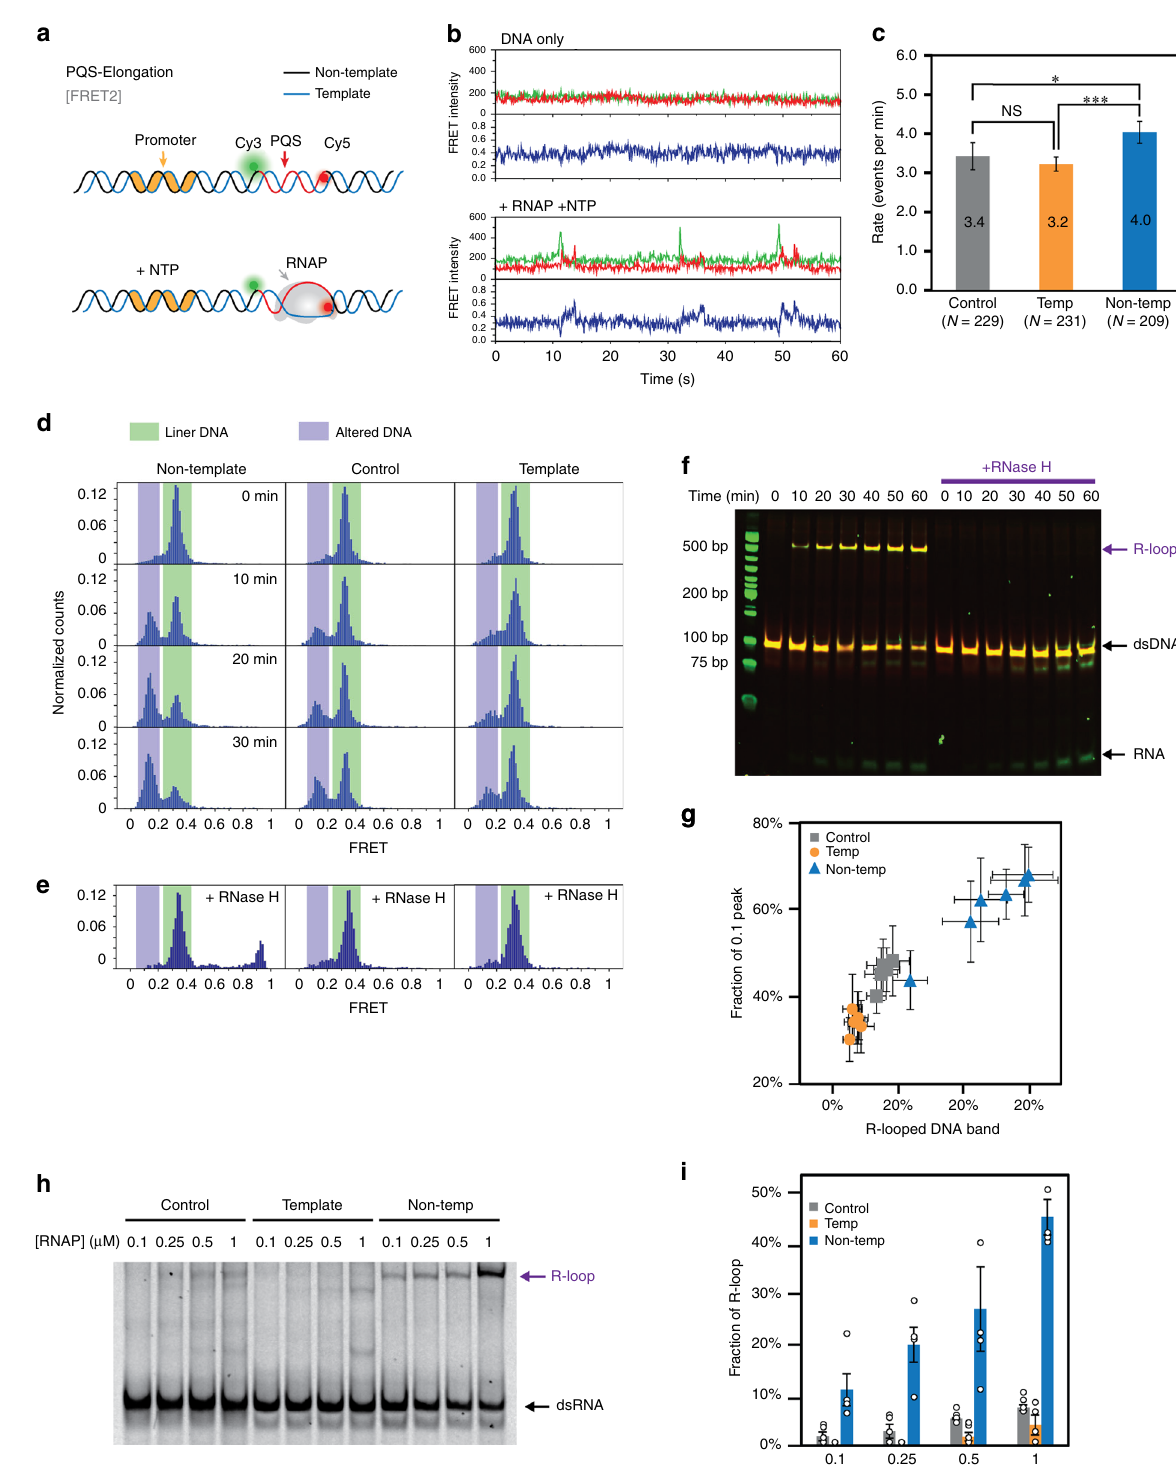
0.25 and 0.4, but no peak at 0.9 consistent with no G4 formation. Only the 0.4 peak was removed by RNase H treatment, con fi rming that 0.4 correspond to R-loop in both constructs and the 0.9 peak represents G4 folding only seen in PQS-NT. Furthermore, the smFRET3 (PQS-NT) trajectories reveal several mechanistic details (Fig. 7d). First, the dynamic exchange between 0.25 and 0.4 FRET states indicates that the R-loop can form transiently and can return back to the duplexed form.